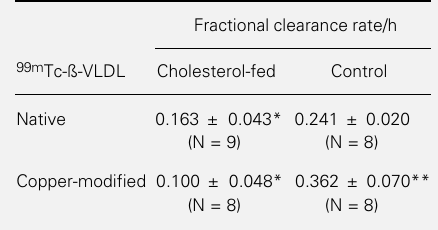
Table 2 - Removal of native and copper-modified 99m Tc-labeled ß-VLDL from plasma of cholesterol-fed and control